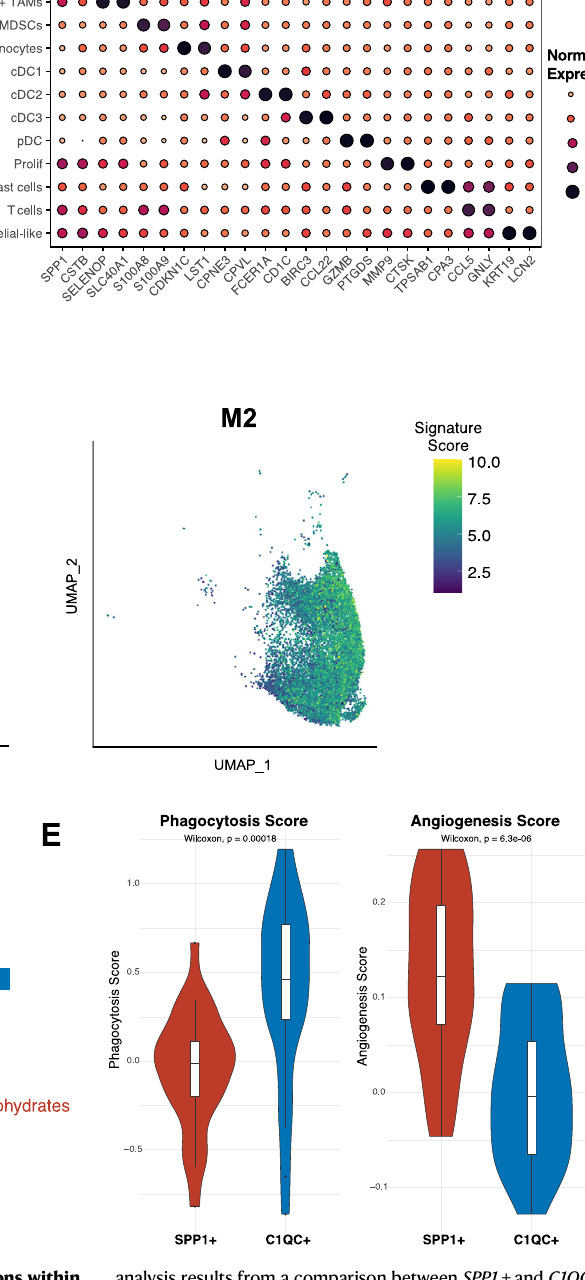
analysis results from a comparison between SPP1 +and C1QC +TAMs. EMT, epithelial-mesenchymal transition. E Phagocytosis and angiogenesis scores for SPP 1 +and C1QC +TAMs. One sample with fewer than 40 total TAM cells was excluded. ( n =26 samples; two-sided Wilcoxon rank-sum test; box plots centered around the median with hinges at 1 st and 3 rd quartiles and whiskers from hinge to max value or 1.5*IQR, whichever is